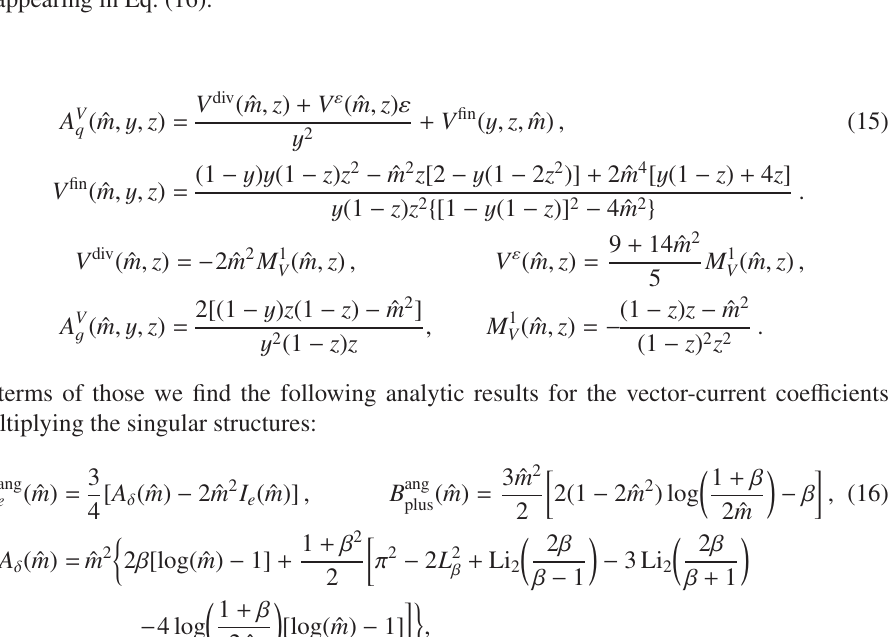
Figure 5: Coe ffi cients of the singular structures for the vector-current di ff erential distribution, as appearing in Eq.